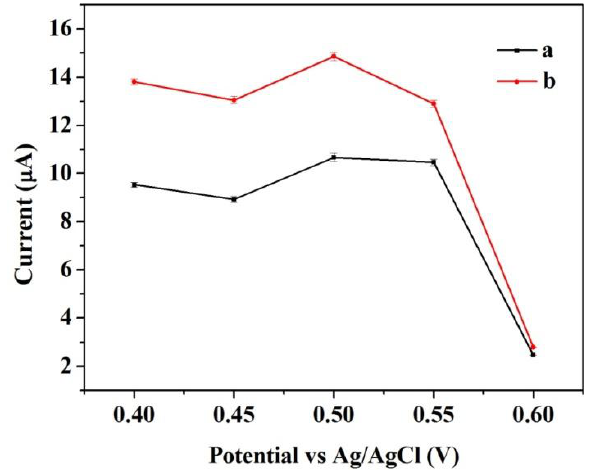
Figure 6. The dependence of the response of ( a ) CNFs/Lac/Nafion/GCE and ( b ) Cu/CNFs/Lac/Nafion/GCE to an input of 3.92 × 10 −4 M catechol on the operating potential. Conditions: pH 5.5 (a), pH 6.0 (b). The error bars indicate the standard error for triplicate measurements with the same